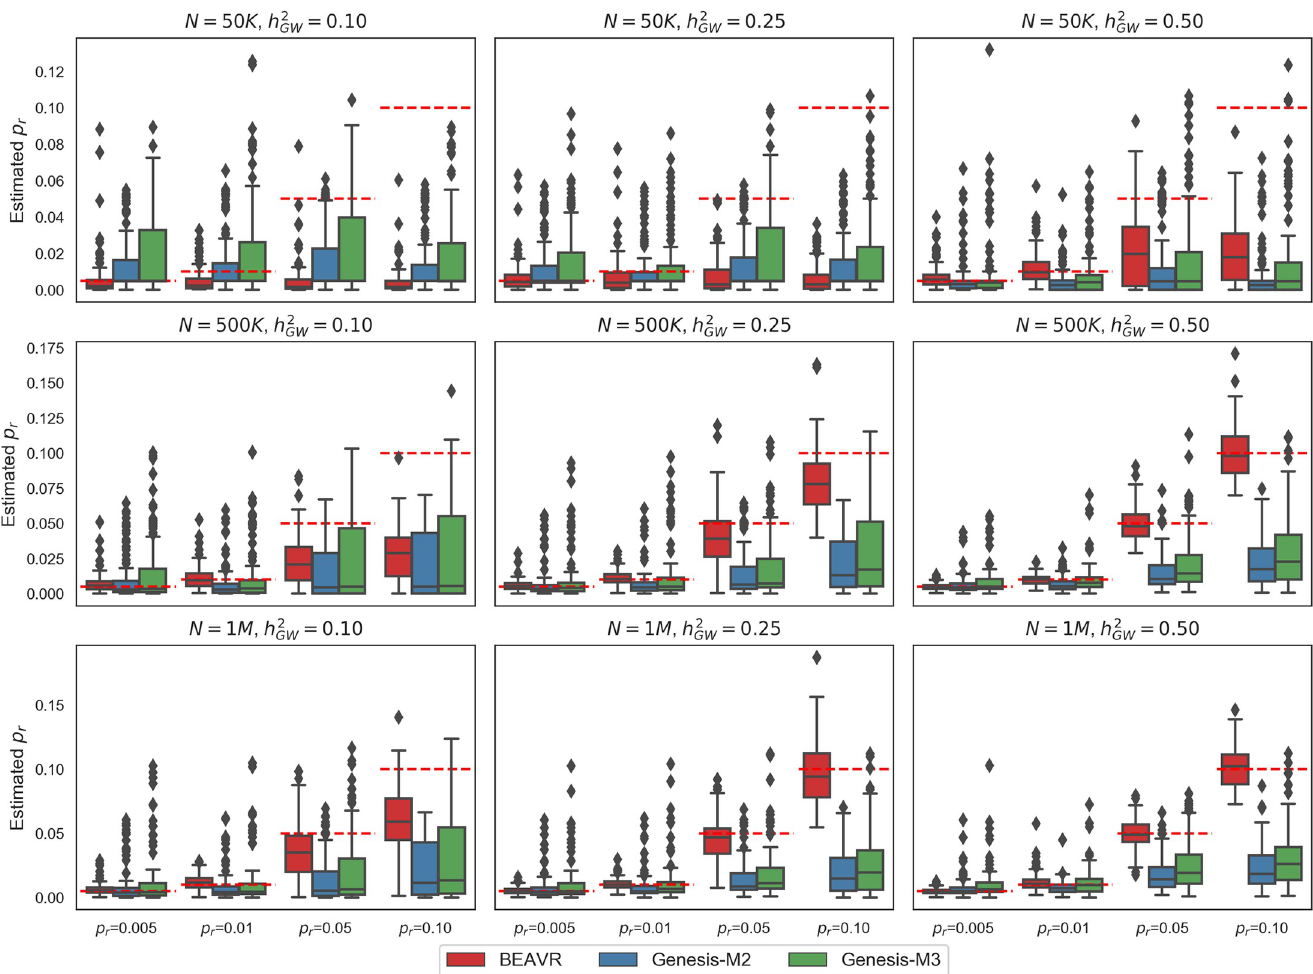
Fig 2. BEAVR is relatively unbiased across various genetic architectures. We ran 100 replicates where we vary the genome-wide heritability to be h 2 = 0.005, 0.01, 0.05, 0.10, and the sample size N = 50K, 500K, 1 million individuals. We compared BEAVR to GENESIS-M2 0.5, the polygenicity of the region to be p r (2-component) and GENESIS-M3 (3-component). The x-axis denotes the simulated values for the regional polygenicity and the y-axis denotes the estimated values across 100 replicates. Dashed red lines denote the true regional polygenicity value in each